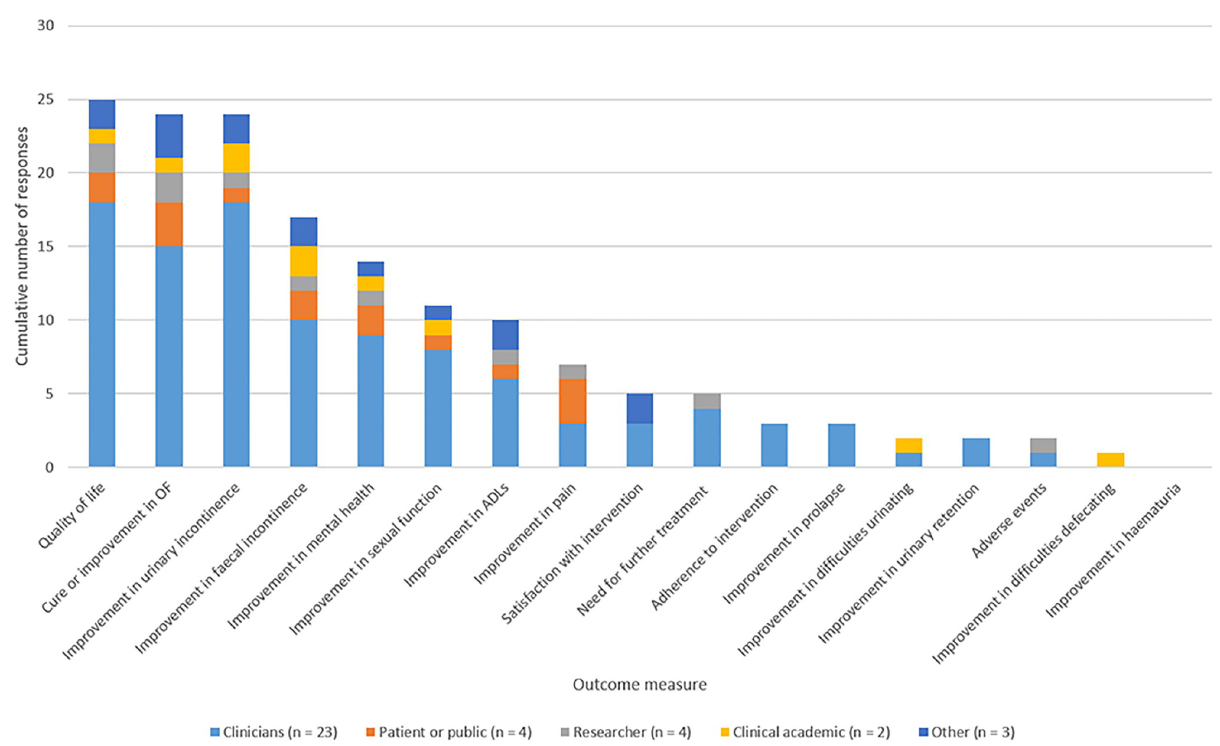
Fig 2. Summary of survey responses relating to outcomes of interest, separated by respondent role.